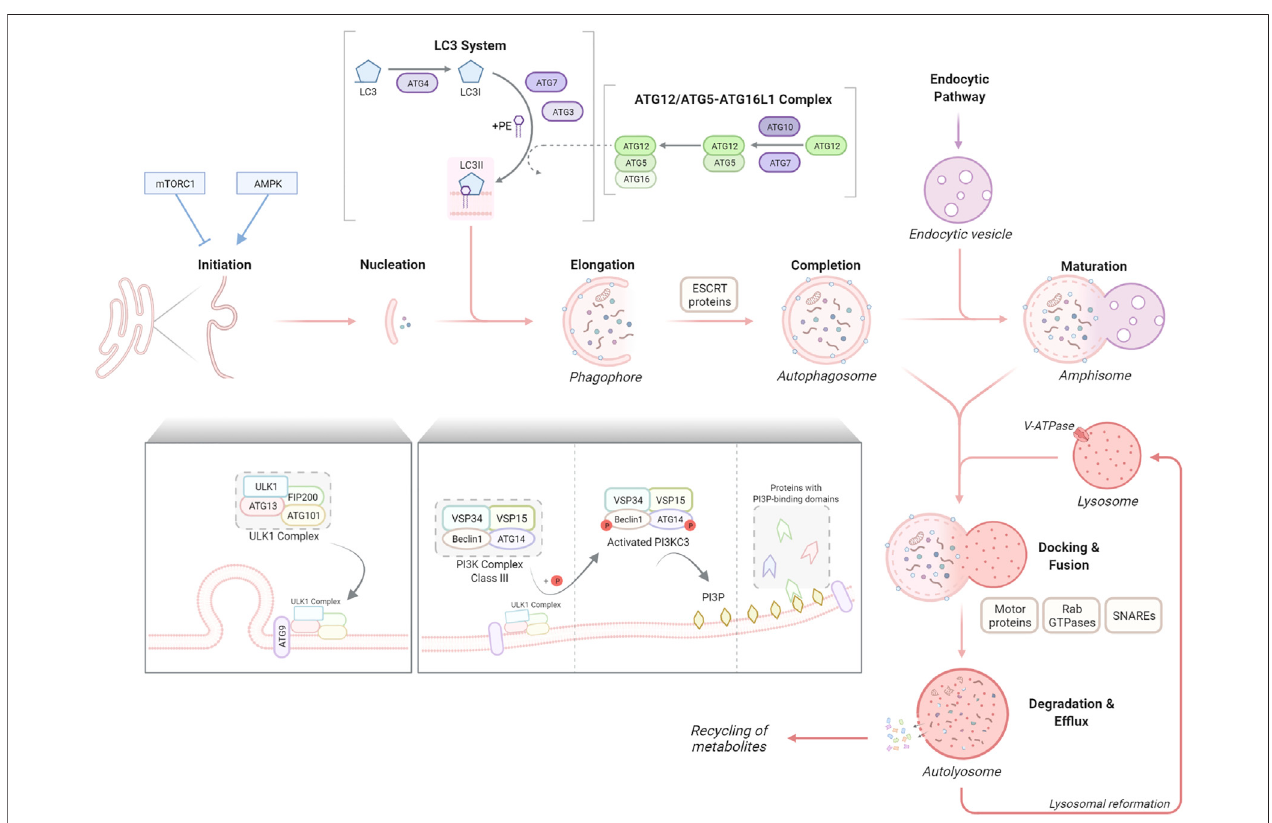
FIGURE 1 | The stages of macroautophagy (autophagy). Autophagy initiation is tightly regulated commonly by two well-known kinases, mTORC1 and AMPK1, which inhibit or promote the activity of the ULK1 complex respectively. The ULK1 complex, consisting of ULK1, ATG13, FIP200 and ATG101, translocates to the autophagosome formation site with the transmembrane spanning ATG9 to stimulate nucleation of the phagophore membrane. The ULK1 complex activates the PI3K complex class III, formed of VSP34, VSP15, Beclin1 and ATG14, resulting in the production of PI3P and recruitment of proteins with PI3P-binding domains. The phagophore elongates, sequestering autophagic cargo for degradation. This elongation process is regulated by two ubiquitin-like reactions, the ATG12/ ATG5 – ATG16L1complexformationand theconjugationofLC3tothelipidanchor PEtoformLC3-II,facilitated byATG7and otherproteins. ESCRT proteins enablethe elongation and fusing of phagophore edges to form the autophagosome which can undergo further maturation through fusion with endocytic vesicles to form amphisomes. Motor proteins, RAB GTPases and SNAREs facilitate the fusion of autophagosomes/amphisomes with lysosomes to form autolysosomes, within which cargo is degraded into metabolites and released for cellular